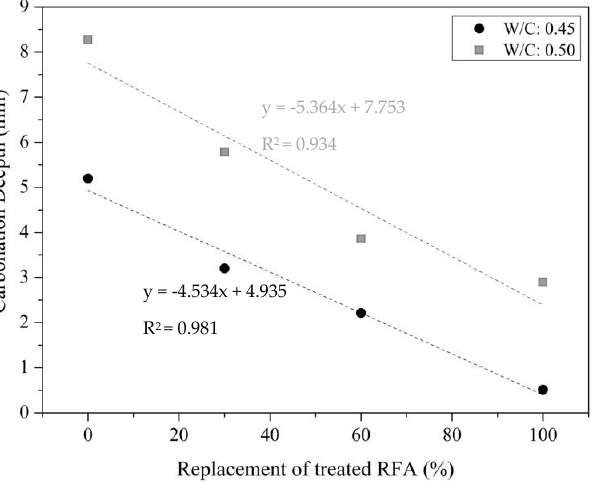
Figure 15. Carbonation depth of mortar made with different replacement of treated RFA at 0.5mol/L – 7d – 20 °C.